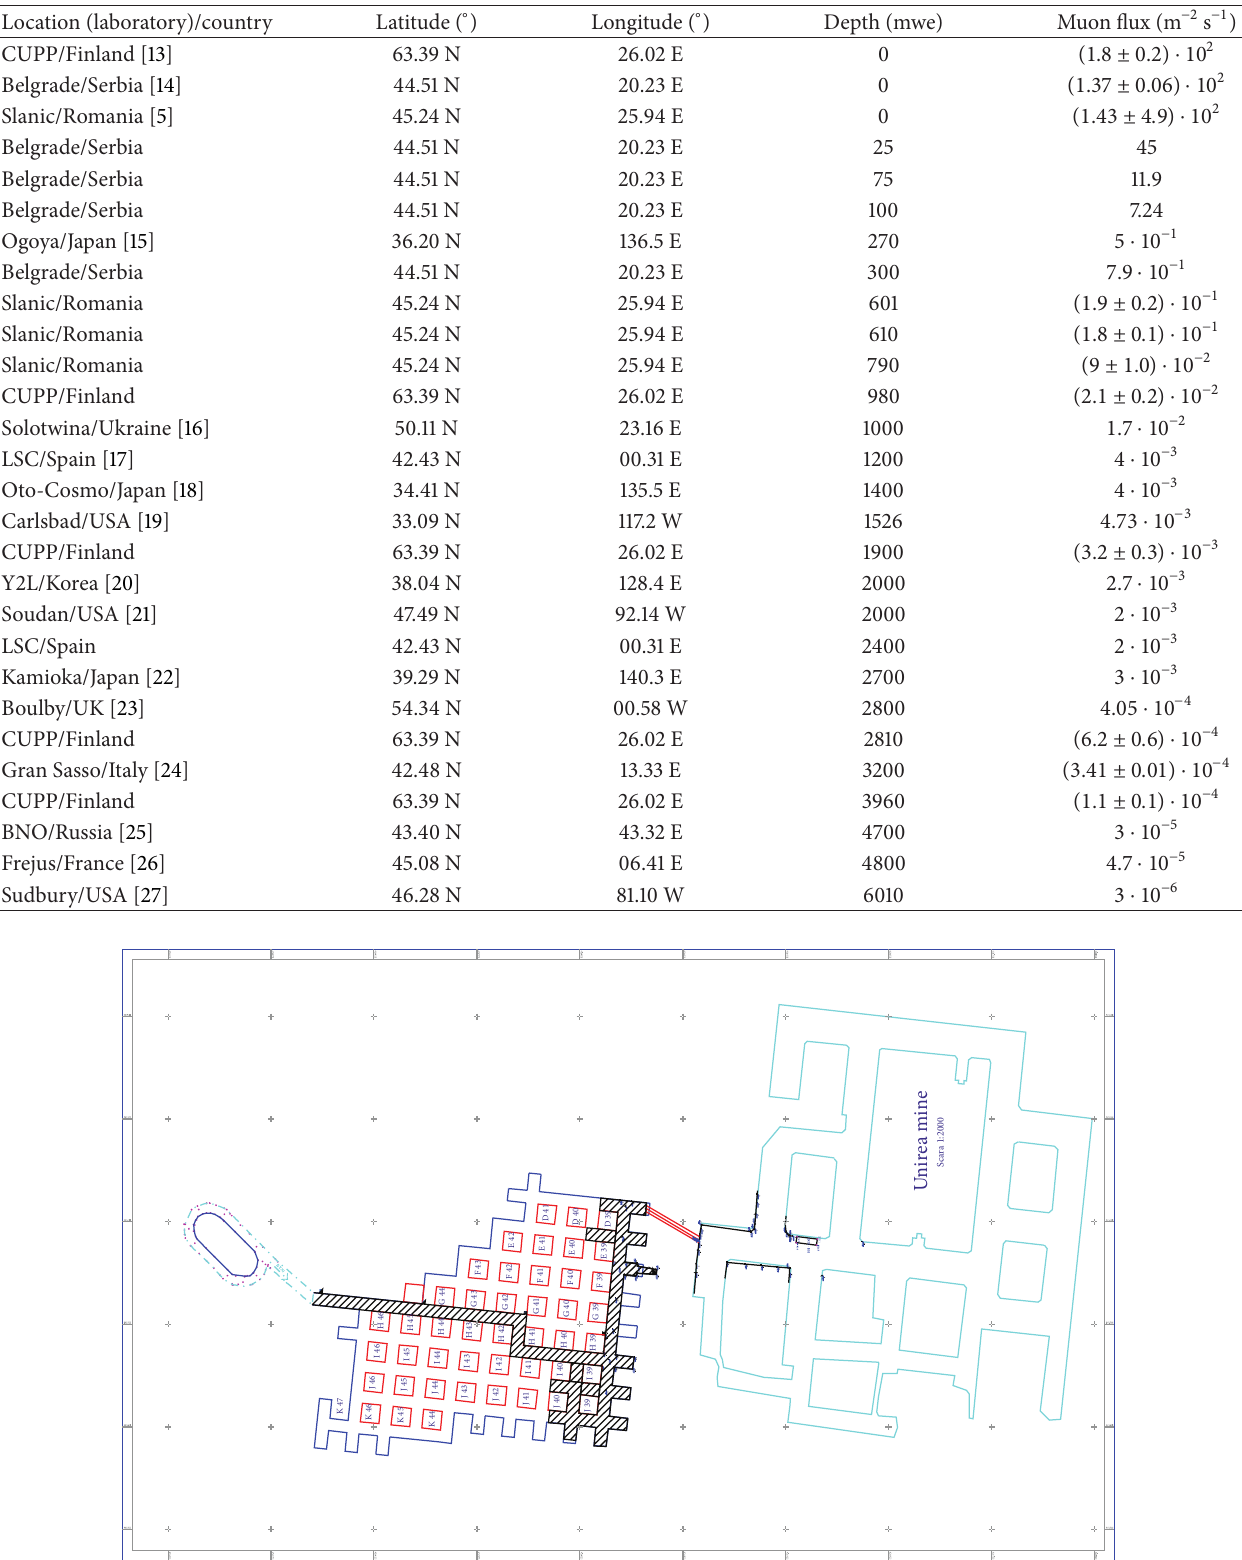
Table 2: A compilation of different muon flux measurements over the world.